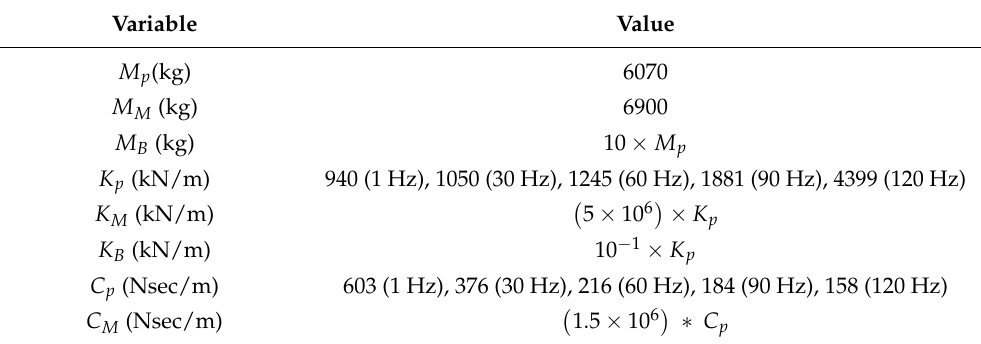
Table 1. Specification of theoretical power plant model [20].